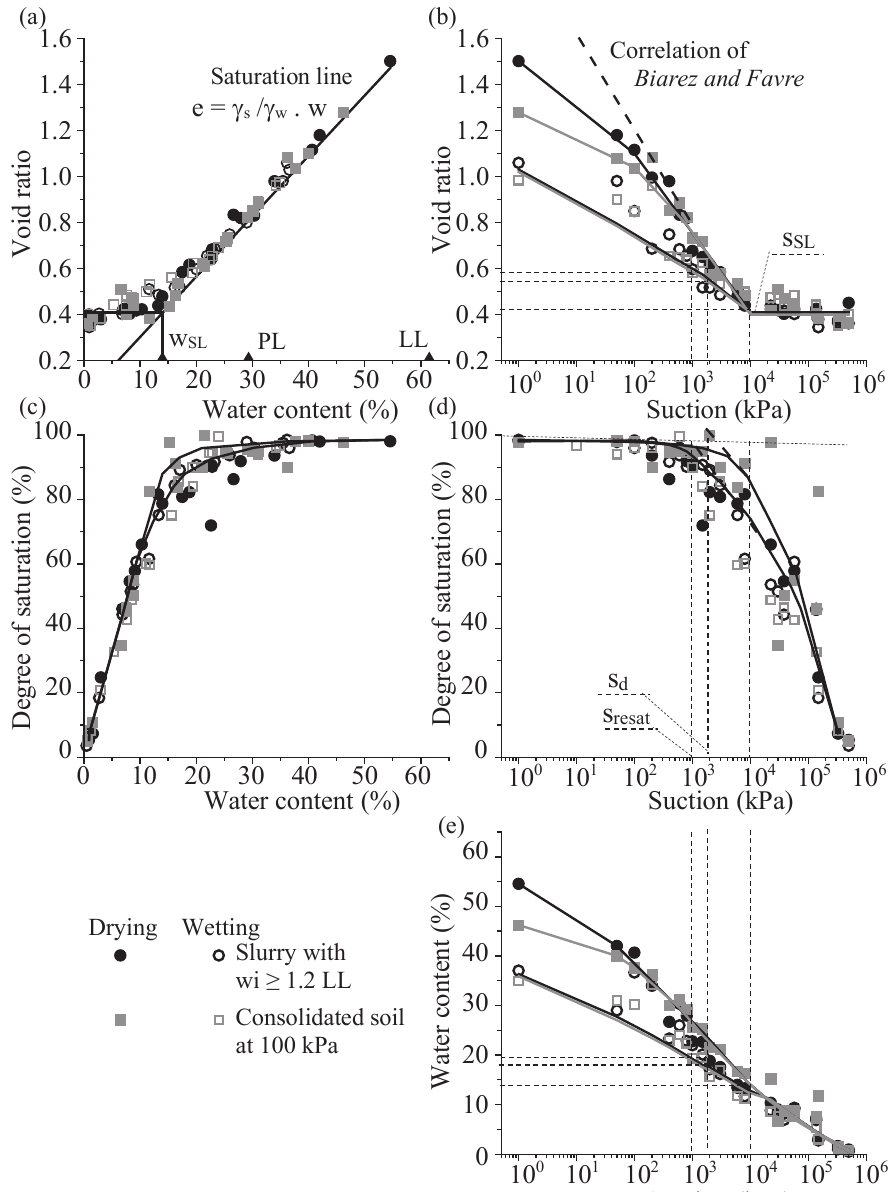
Figure 6: Drying-wetting path on the Boumagueur marl in the form of slurry with w i ≥ 1.2 LL (Test D-W1) and consolidated soil at 100 kPa (Test D-W2). Table 6: Variation of the state parameters as a function of suction domain on drying path.